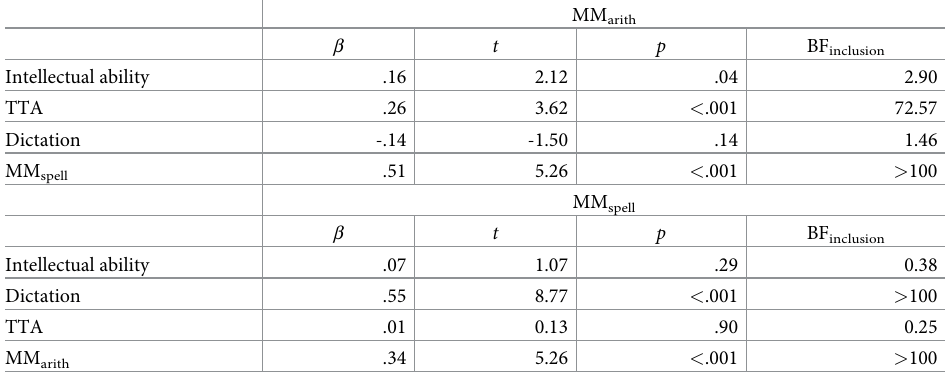
Table 2. Regression analyses of MM arith and MM spell performance with metacognitive monitoring in the other domain and standardized task performance in both domains as predictors.